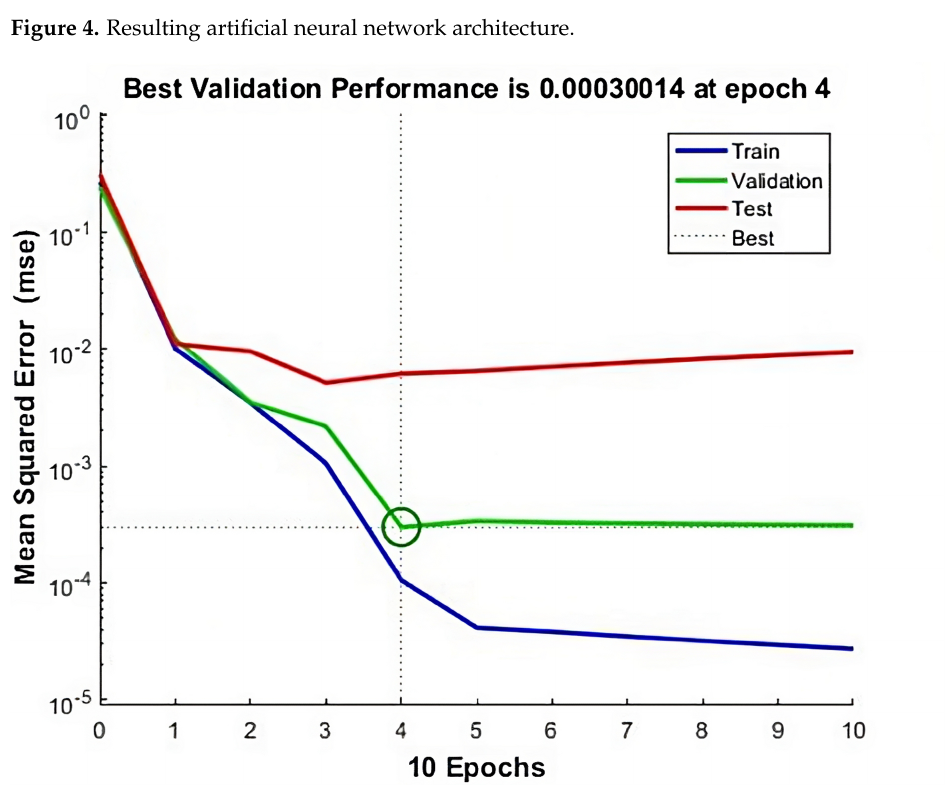
Figure 5. Performance plot of the artificial neural network training